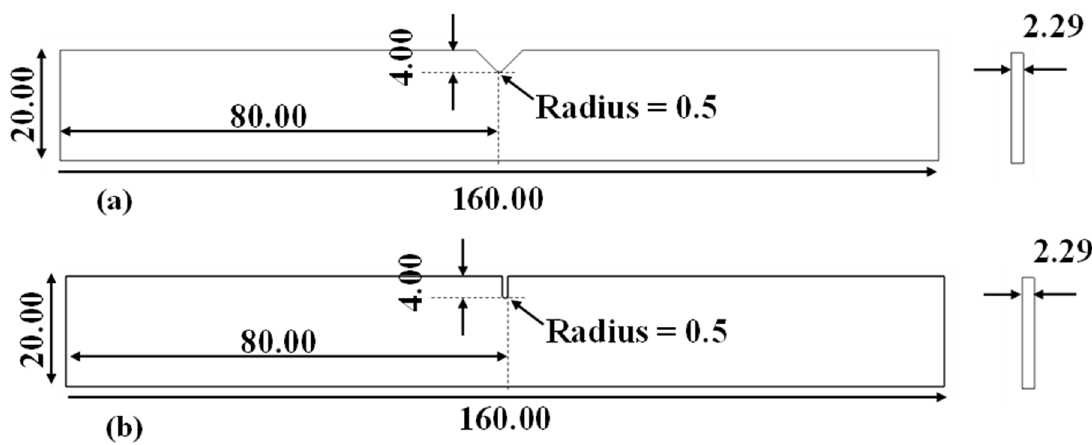
Figure 2. Geometry of the one-sided ( a ) V-notched; ( b ) U-notched specimens (all dimensions are in mm).